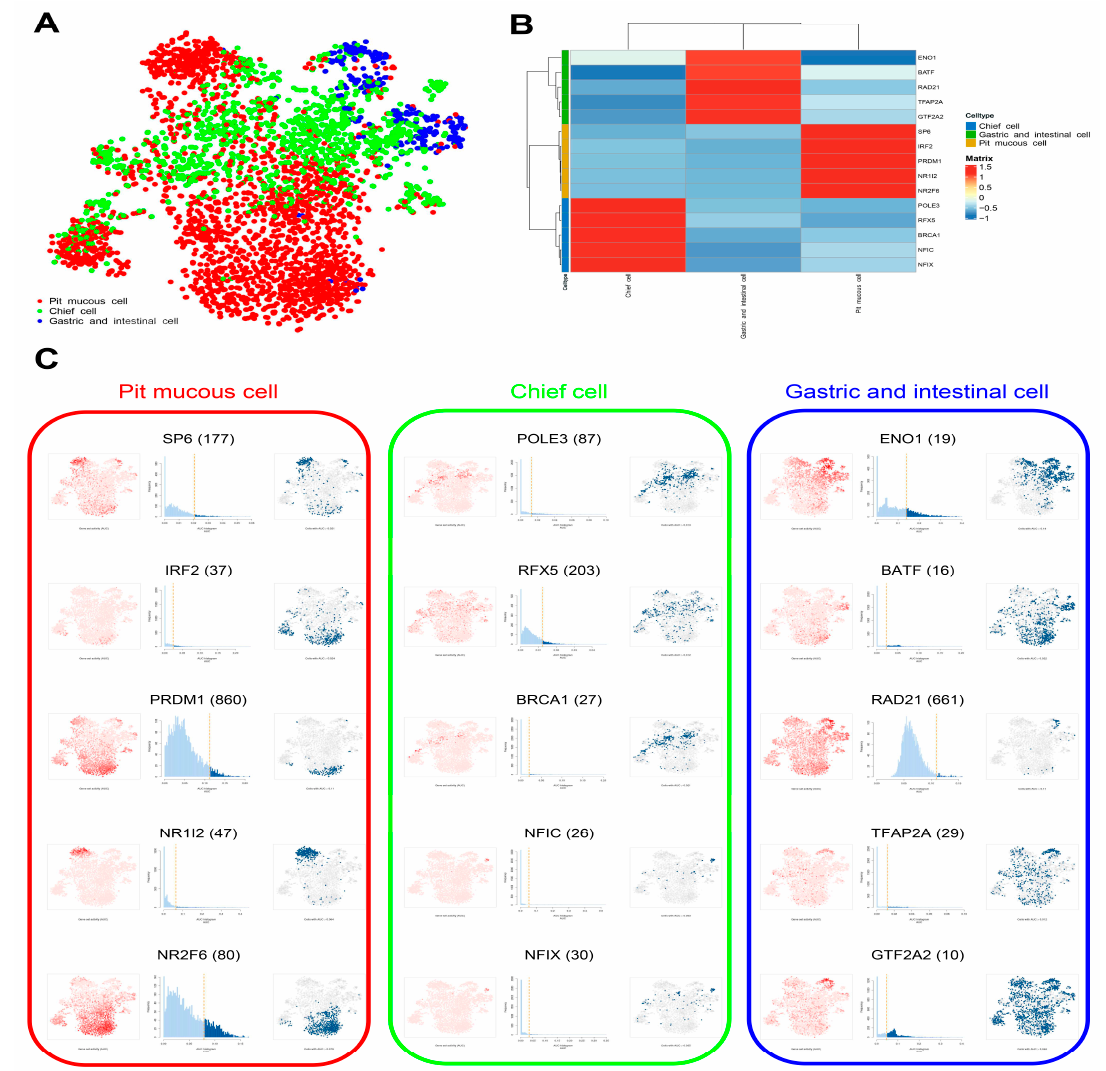
Figure 9. The SCENIC analysis predicted the TF. ( A ) tSNE plot showing the TF in three subtypes of malignant epithelial cells. ( B ) Heatmap showing the top 5 TF in three subtypes of malignant epithelial cells. ( C ) tSNE plots and histograms show the top 5 TF activities in three subtypes of malignant epithelial